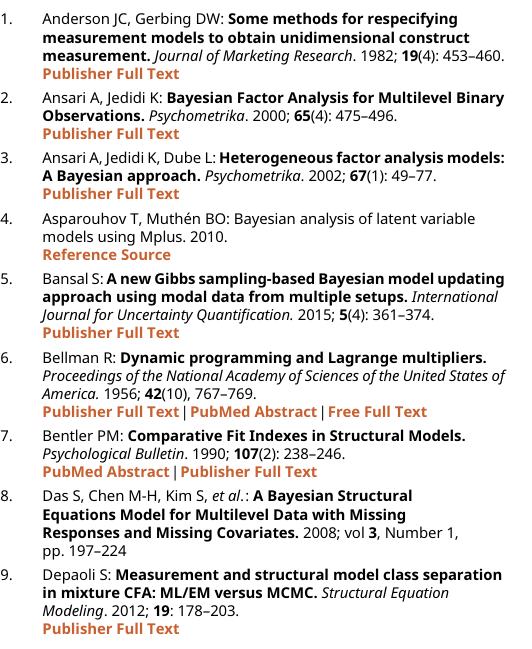
Figshare: RCODE BSEM.docx. https://doi.org/10.6084/m9.figshare.19299851. 26